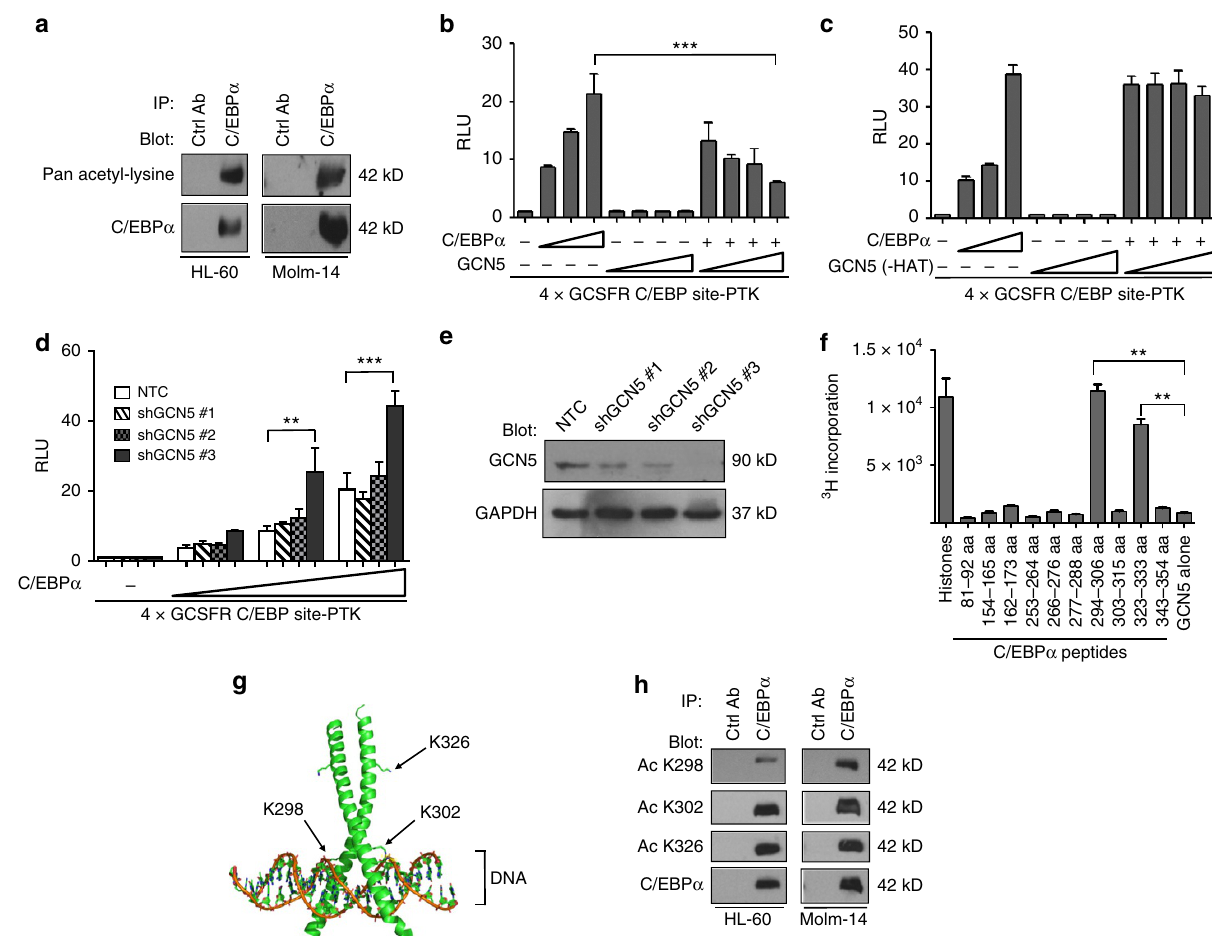
Figure 1 | GCN5-mediated acetylation of C/EBP a is linked to loss of transcriptional activity. ( a ) Western blot analysis with anti-pan-acetyl-lysine antibody following immunoprecipitation (IP) of C/EBP a with rabbit anti-C/EBP a in HL-60 and Molm-14 human myeloid cell lysates. Rabbit anti-GFP antibody was used as IP control. ( b , c ) GCN5 decreases the ability of C/EBP a to transactivate a minimal p(CEBP) 4 TK promoter in a dose-dependent manner and is dependent on the GCN5 histone acetyltransferase (HAT) domain. 293Tcells were transiently transfected with p(CEBP) 4 TK, pRL-null, and pcDNA6 expression plasmids for C/EBP a and with GCN5 or GCN5 (-HAT), respectively. Protein expression of corresponding constructs were shown in Supplementary Fig. 1c. Luciferase activity was measured in duplicate for each experiment and data are shown as mean ± s.d. ( N ¼ 3). ( d ) Knockdown of endogenous GCN5 results in an increase in C/EBP a transactivation potential. GCN5 knockdown in 293Tcells enhanced C/EBP a transactivation capacity on a minimal p(CEBP) 4 TK promoter with pRL-null and pcDNA6 C/EBP a plasmids. Firefly luciferase readings were normalized against internal control renilla luciferase. Luciferase activity was measured in duplicate for each experiment and data are shown as mean ± s.d. ( N ¼ 3). ( e ) Western blot demonstrating knockdown efficiencies of endogenous GCN5 by 3 different shRNAs in 293Tcells used in d . ( f ) GCN5 acetylates C/EBP a at K298, K302 and K326. C/EBP a peptides were incubated with the GST-HAT domain of GCN5 in the presence of 3 H-labeled acetyl-CoA. Tritium incorporation by C/EBP a peptides was measured by scintillation counting. Error bars represent mean ± s.e.m. Experiments were performed twice in duplicate. ( g ) Structure of the C/EBP a basic region-leucine zipper domain bound to DNA. Arrows indicate the location of the acetylated lysine residues. ( h ) Endogenous C/EBP a is acetylated in the basic leucine zipper region in HL-60 and Molm-14 cells. C/EBP a protein was immunoprecipitated using a rabbit antibody recognizing total C/EBP a protein, followed by immunoblotting against acetylated C/EBP a antibodies (K298, K302, and K326). Rabbit anti-GFP antibody was used as a control for IP. ** P o 0.01 and *** P o 0.001; Student’s unpaired t -test ( b , d and f ).